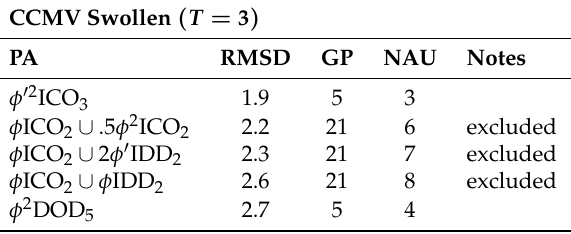
Table 4. At first glance, there appear to be several point arrays tied for the best fit of the swollen CCMV particle; however 3 of these were excluded based on poor agreement with the gauge points (Figure